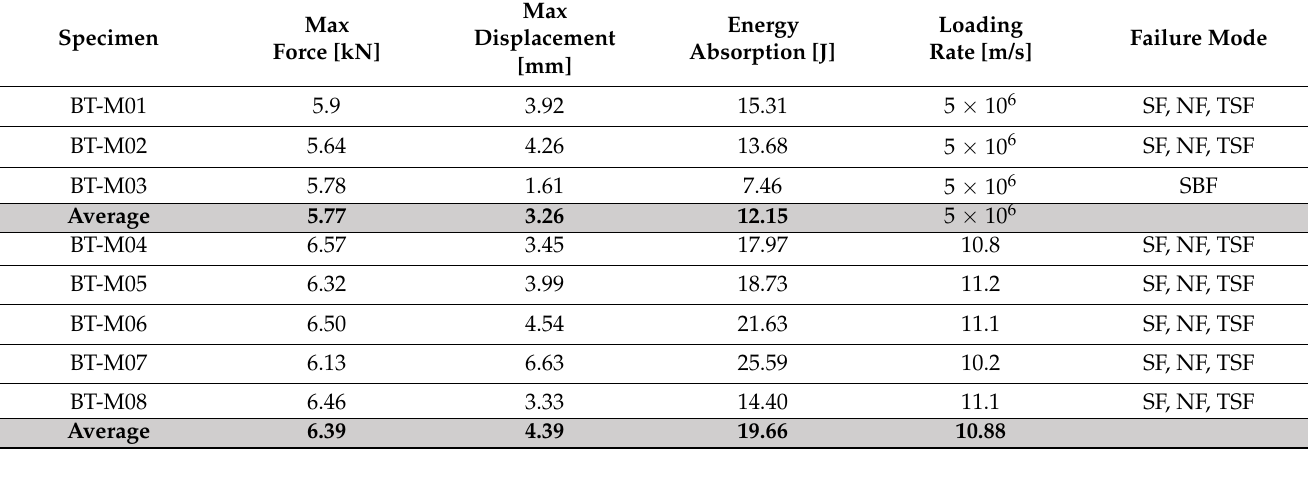
Table 1. Results of the multi-material bolted joints (NF—net tension failure, SF—shear-out failure, SBF—bolt shear failure, TSF—tension and shear-out failure).